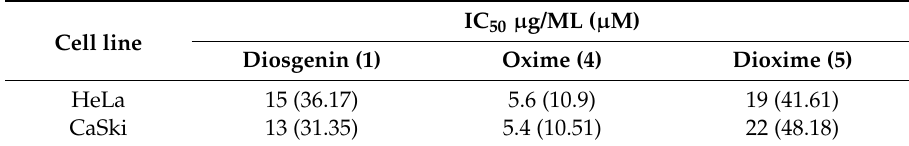
Figure 3. Dose-response curves of the antiproliferative effect of compounds 1 , 4 , and 5 on cervicouterine cancer cell lines HeLa and CaSki. Cisplatin was used as positive control. Table 1. IC 50 values of compounds 1 , 4 , and 5 on cervicouterine cancer cell lines HeLa and